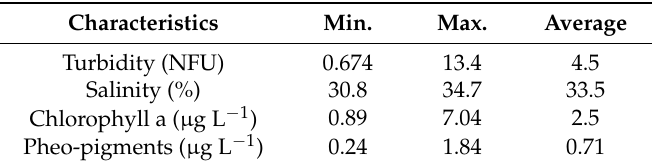
Table 1. Natural seawater